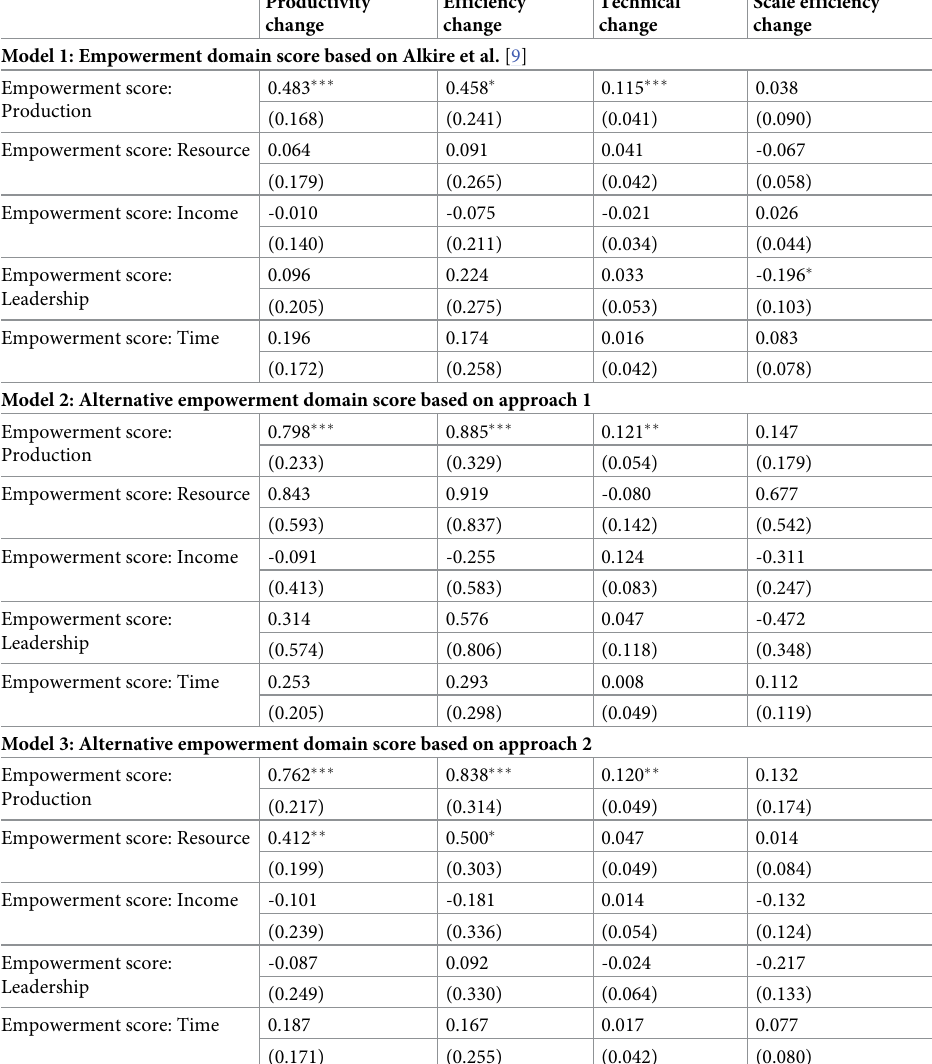
Table 8. Results of the OLS bootstrap regression of the determinants of farm productivity change and its compo- nents (WEAI domains).